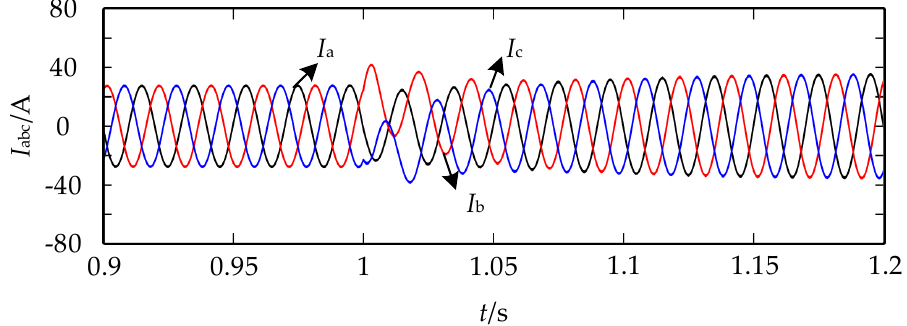
Figure 14. Three ‐ phase current with no negative sequence.